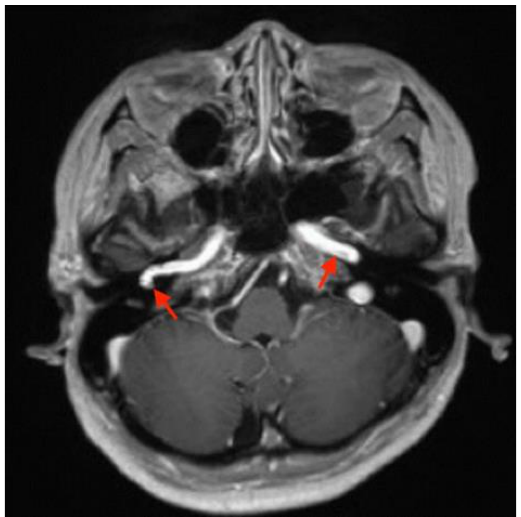
Figure 5. Gadolinium-enhanced magnetic resonance image revealing a normal left internal carotid artery (ICA) (arrow on the patient’s left) and lateral bulging of the right ICA to the right of the tympanic cavity (arrow on the patient’s right) in the axial view.